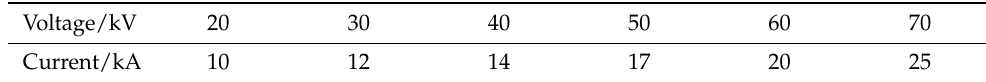
Table 1. The actual test device obtained the data in the Table 1. Table 1. Simulation reference ground current Table 1. Simulation reference ground current peaks.